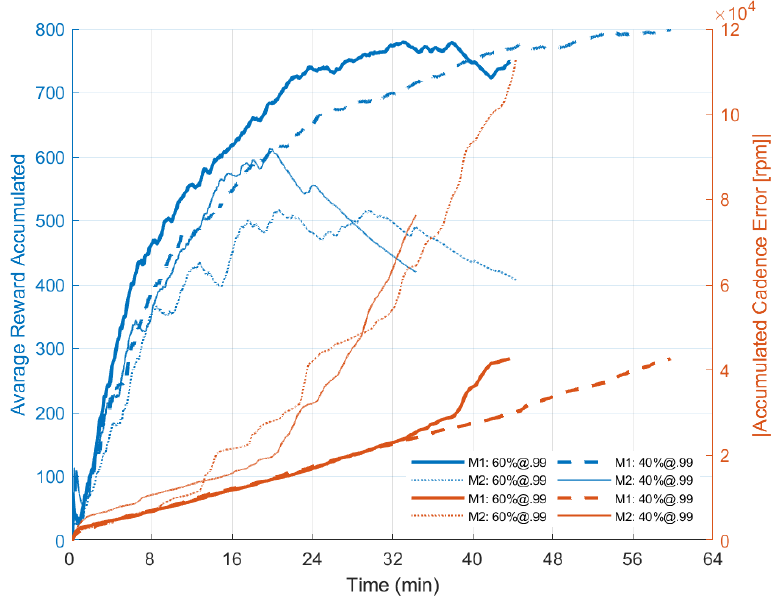
Figure 5. Reward over time during cycling sessions and the accumulated absolute value of cadence error. The agent’s ability to explore different actions over time to increase the reward received can be interpreted as its ability to learn the best action for the time-varying scenario of FES-cycling. Data were obtained from the Android App with a sample frequency @10 Hz.